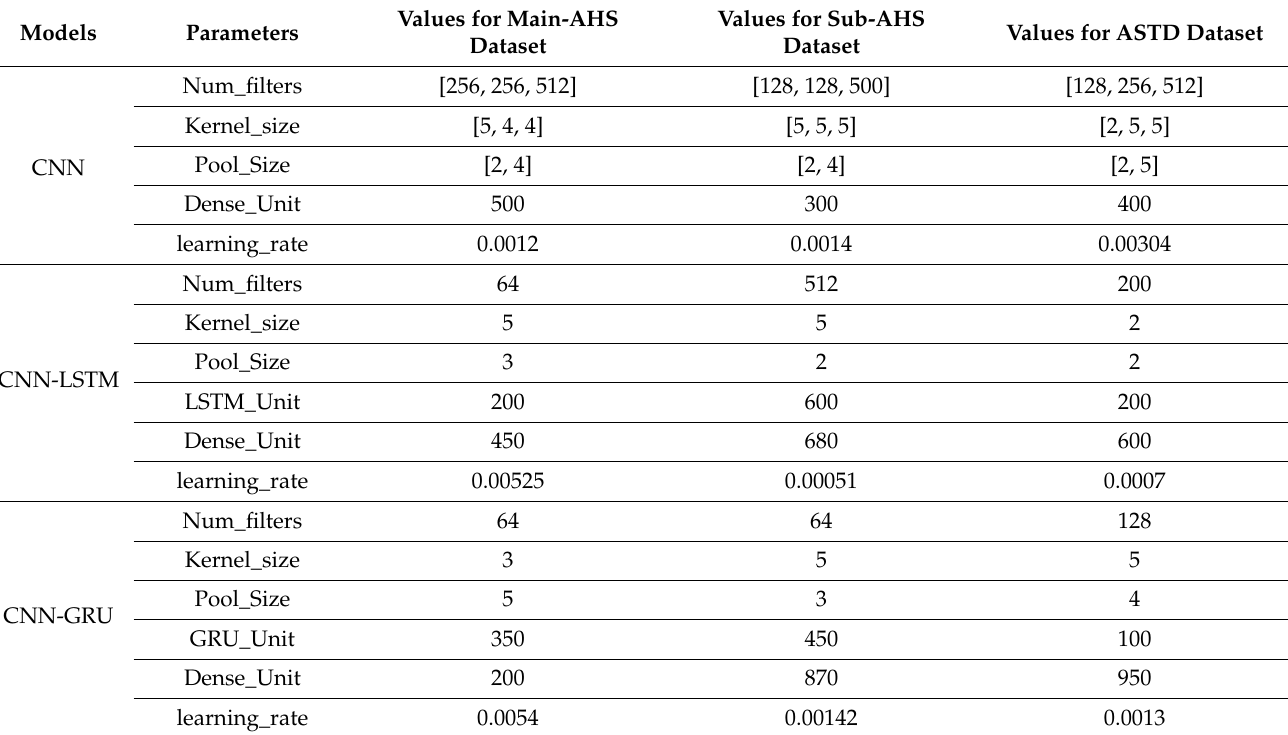
Table 3. Values of parameters after applying DeepCNN, CNN-LSTM and CNN-GRU models with